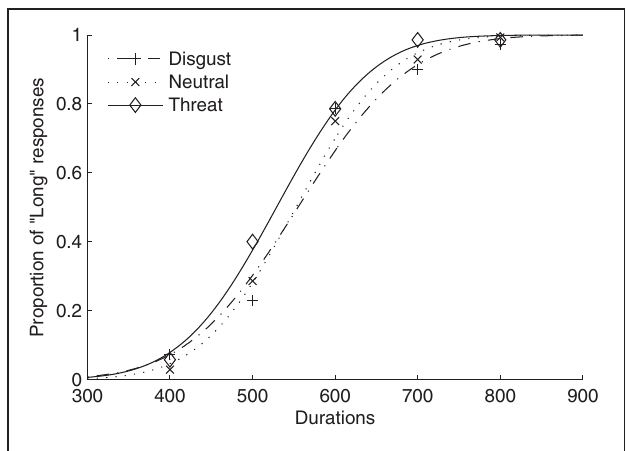
FIGURE 1 | Mean proportions of “Long” responses plotted against probe durations and fitted psychometric functions for three emotion conditions (neutral, threat, and disgust). The dotted curve and crosses represent the neutral condition, the dash-dotted curve and pluses the disgust condition, and the solid curve and diamonds the threat condition.